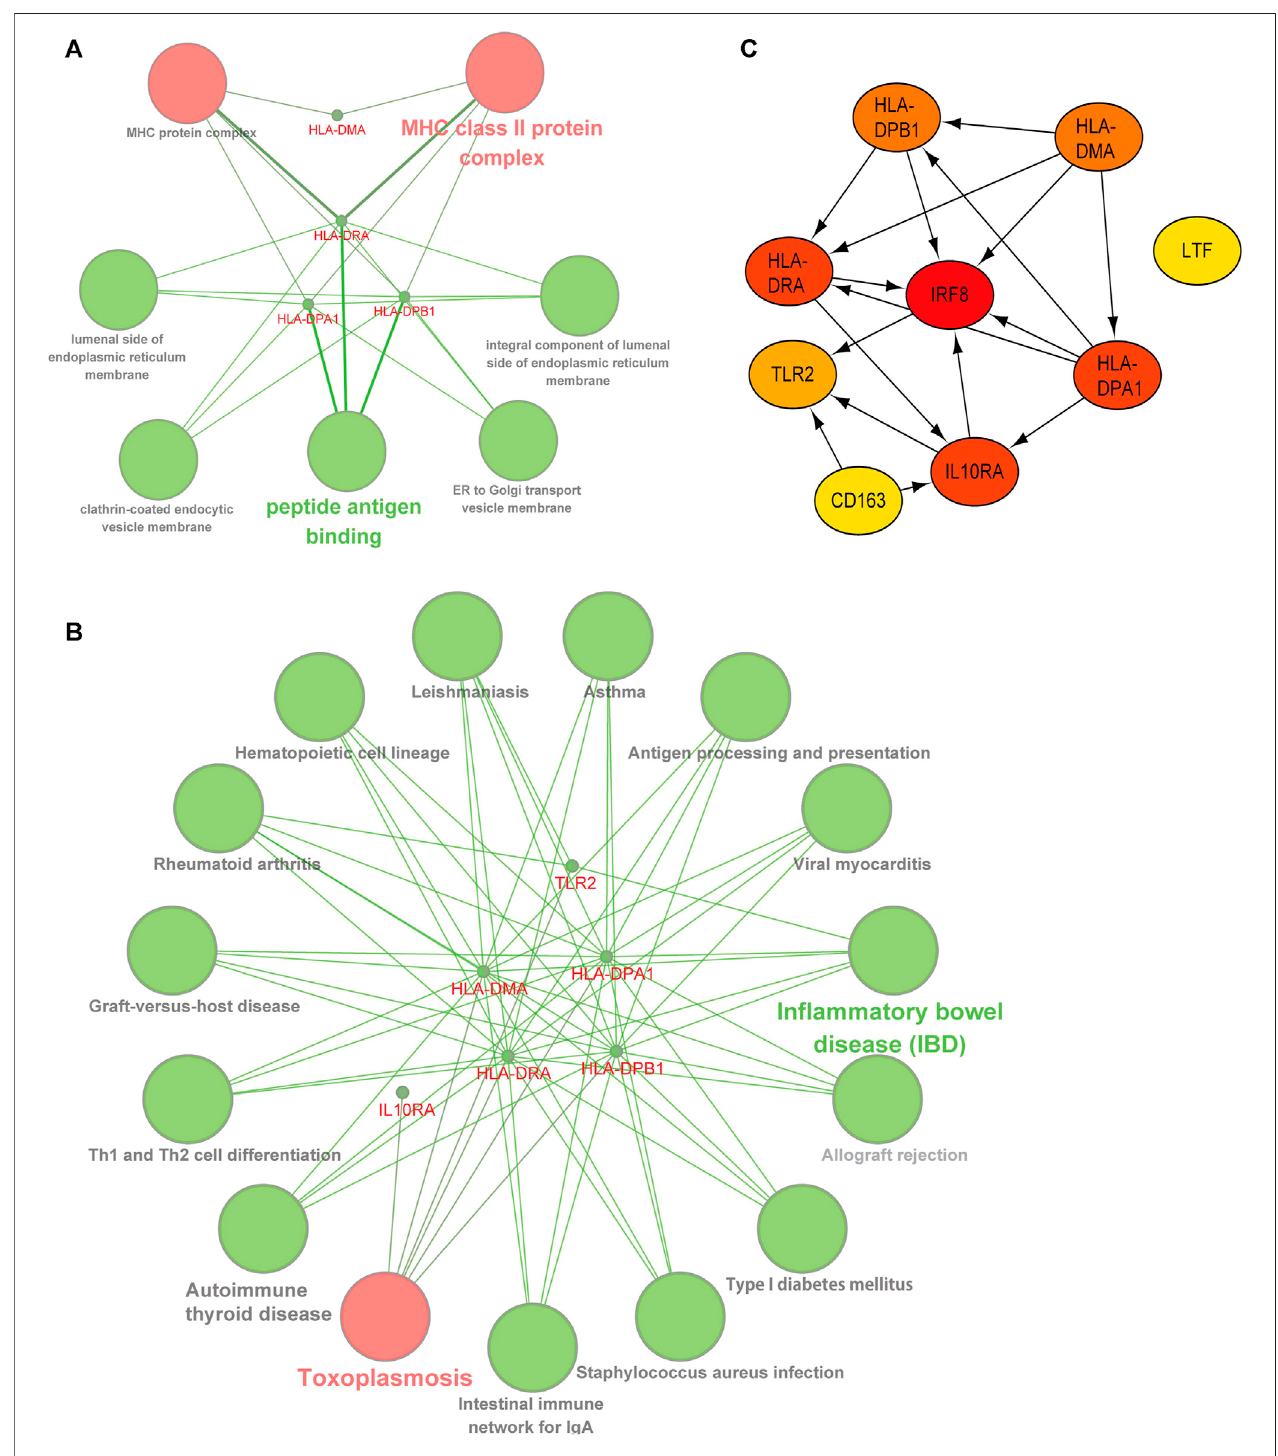
FIGURE4|| Functionalandpathwayanalysisofco-DEGs. (A) GOenrichmentanalysisofco-DEGs. (B) KEGGenrichmentanalysisofco-DEGs. (C) Protein-protein interaction network of co-DEGs, color shades represent the degree size calculated with the cytoHubba plugin.